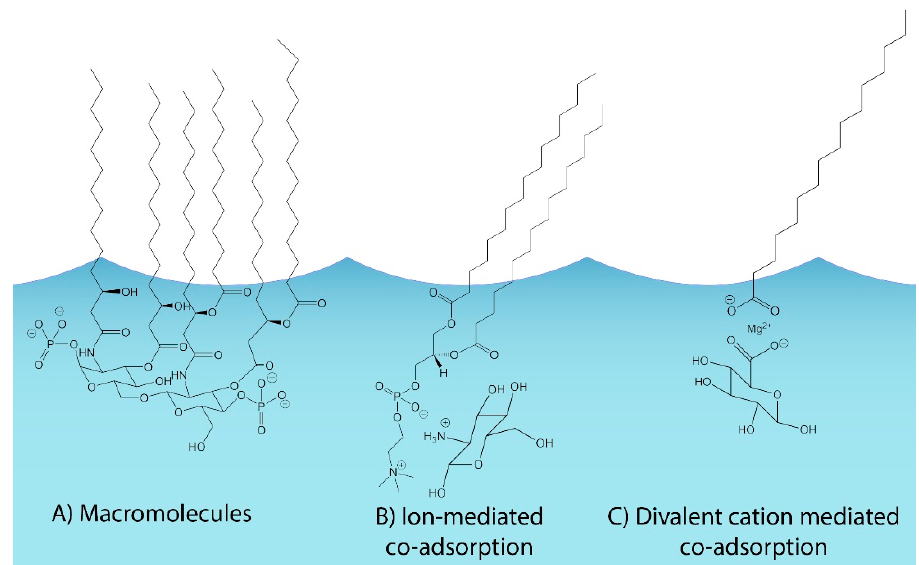
Figure 1. Conceptual overview of soluble organic distribution in the sea surface microlayer (SSML) for the ( A ) macromolecule-derived mechanism, shown here as the lipid A head group of lipopolysaccharides (LPS), ( B ) ion-mediated co-adsorption mechanism put forth by Burrows et al. [57] and ( C ) divalent cation mediated co-adsorption (this paper).